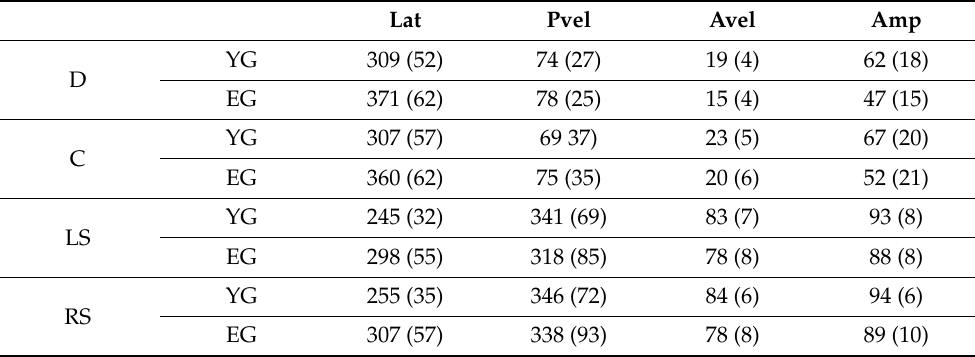
Table 1. Eye movement characteristics depending on the group. Means and sd.